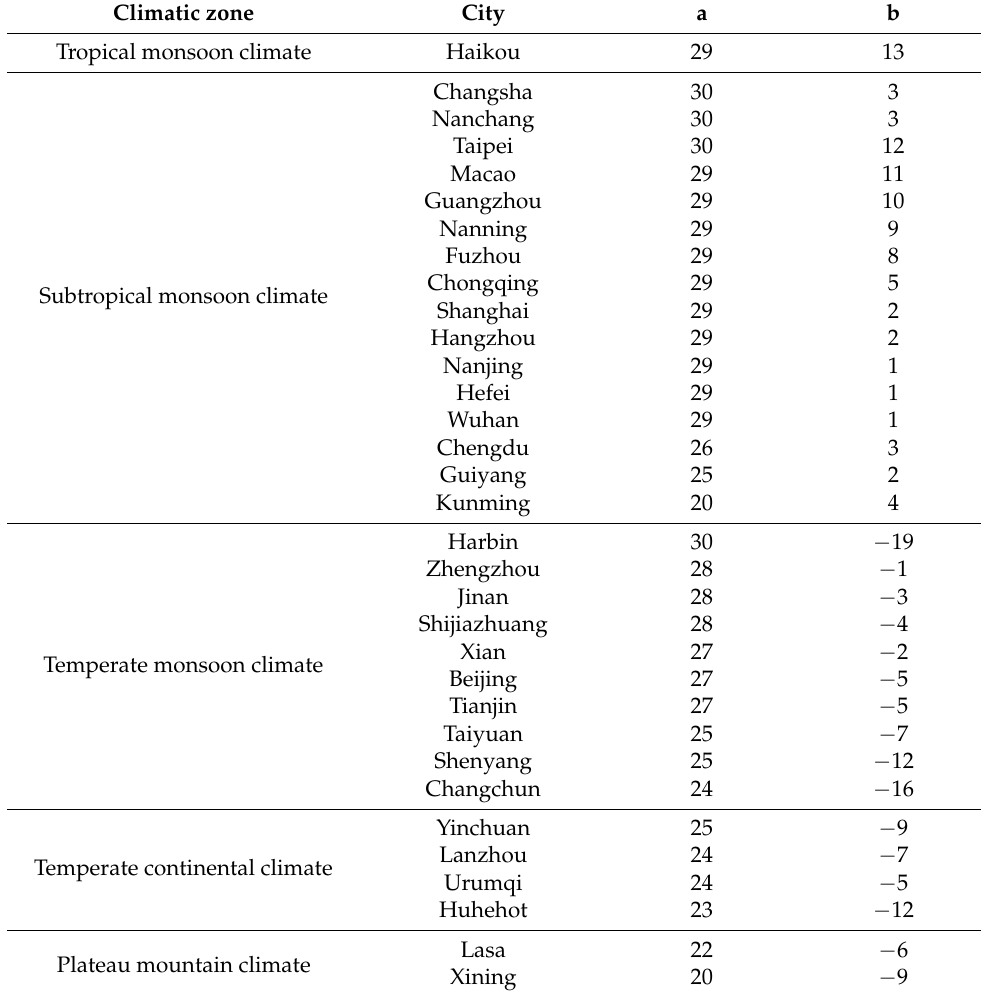
Table 1. Adjustment coefficient of typical regions in